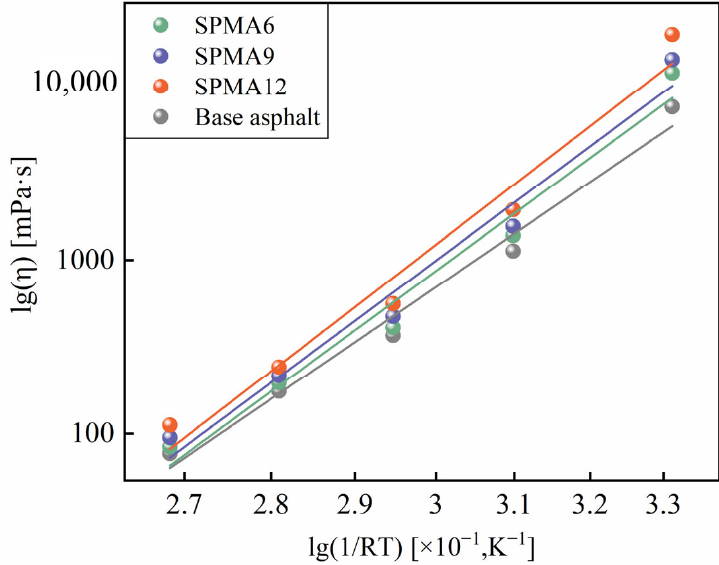
Figure 7. Activation energy of asphalt binders. Table 13. The fitting result of activation energy.